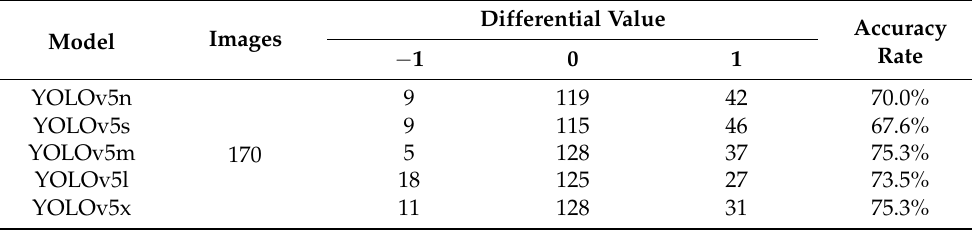
Table 6. The difference distribution in newly appeared leaf